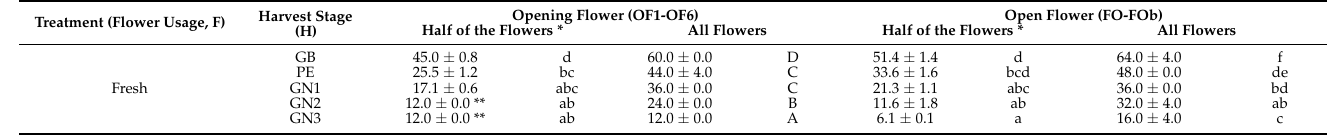
Figure 7. The full flowering period and the mean of the full flowering period throughout the dura- tion of the vase time. Bud stages: green bud (GB); pencil: white bud, upright (PE); goose neck 1: white bud, skew (GN1); goose neck 2: white bud, horizontal (GN2); goose neck 3: big white bud, horizontal, maximum with 1 opening petal (GN3).